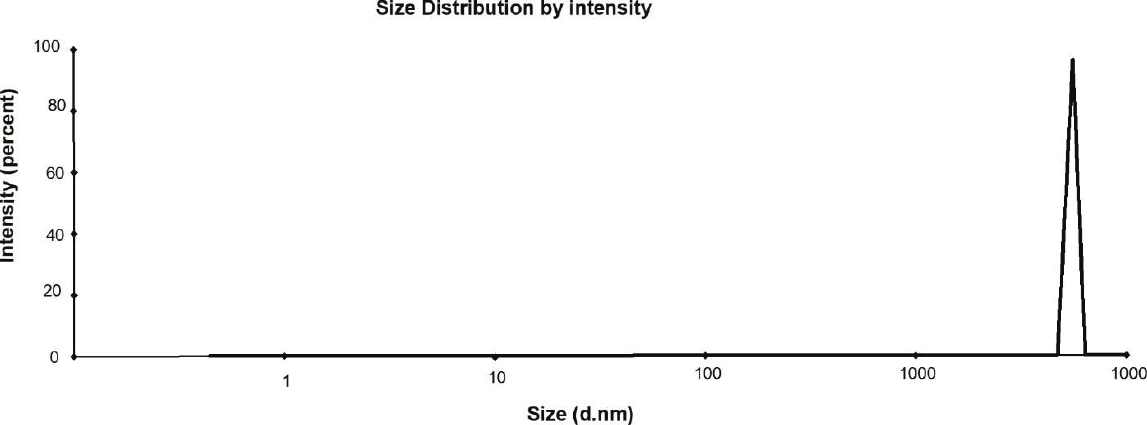
Fig. 7. Size distribution of the selected formula (AZP4)